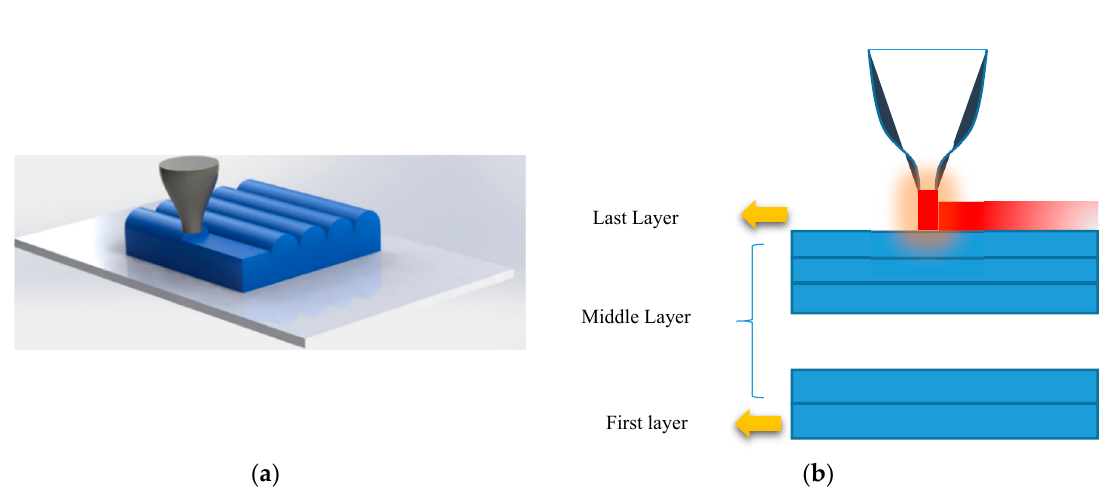
Figure 3. Schematic of the fused deposition modeling (FDM) method.